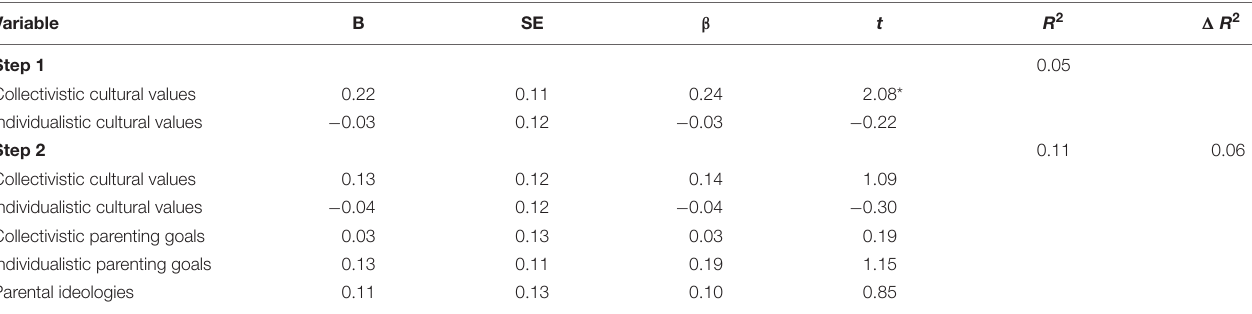
TABLE 7 | Hierarchical regression of multiple predictors of Mainland Chinese mothers’ parenting